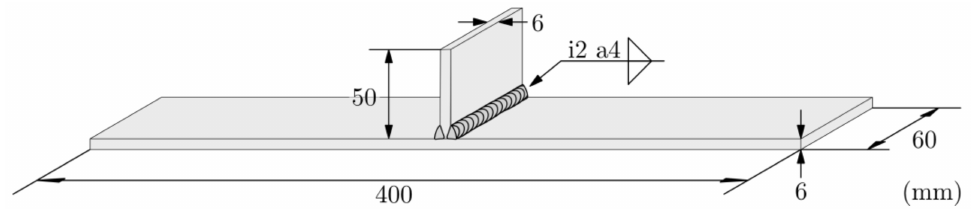
Figure 2. Fatigue test specimen, single-pass tee joint weld